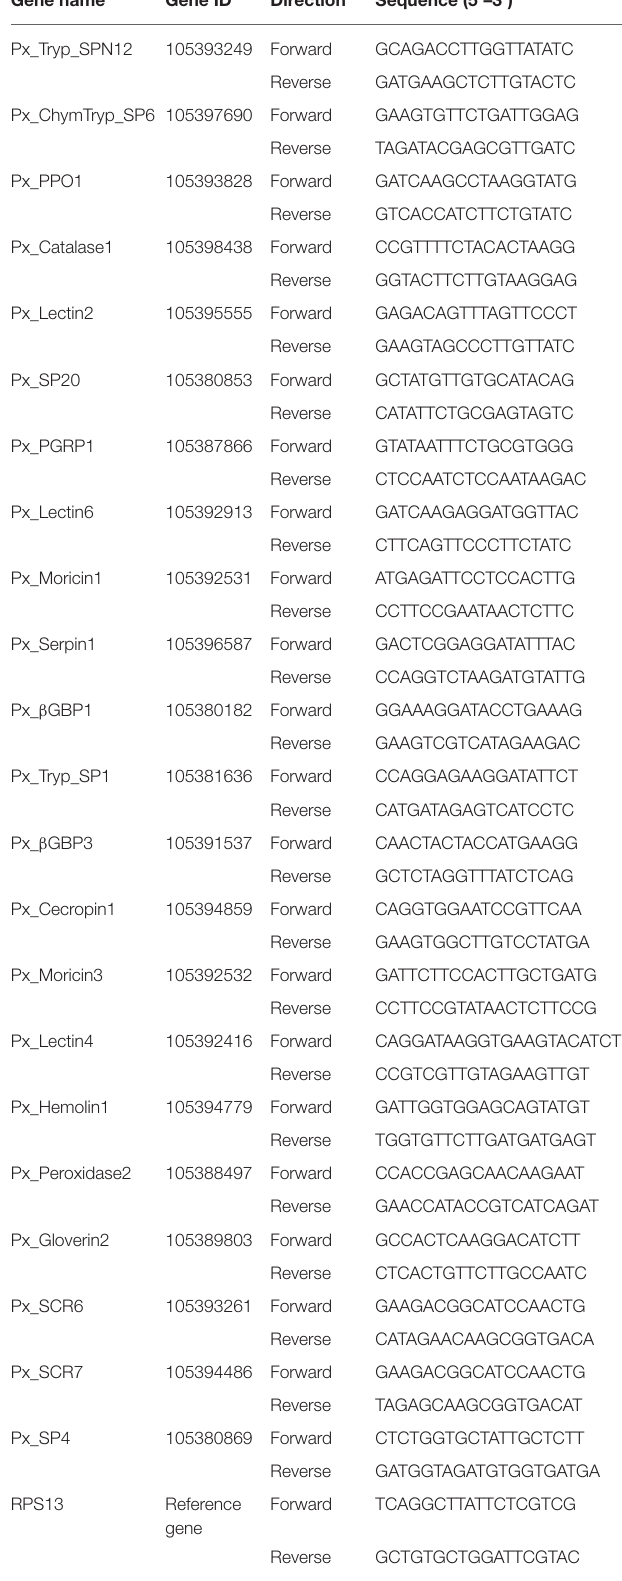
TABLE 1 | Primers used for RT-qPCR in the present